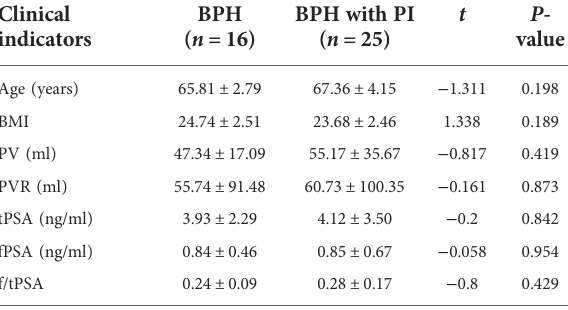
TABLE 1 Comparison of clinical indicators between two groups of patients before surgery (mean±SD). Clinical indicators